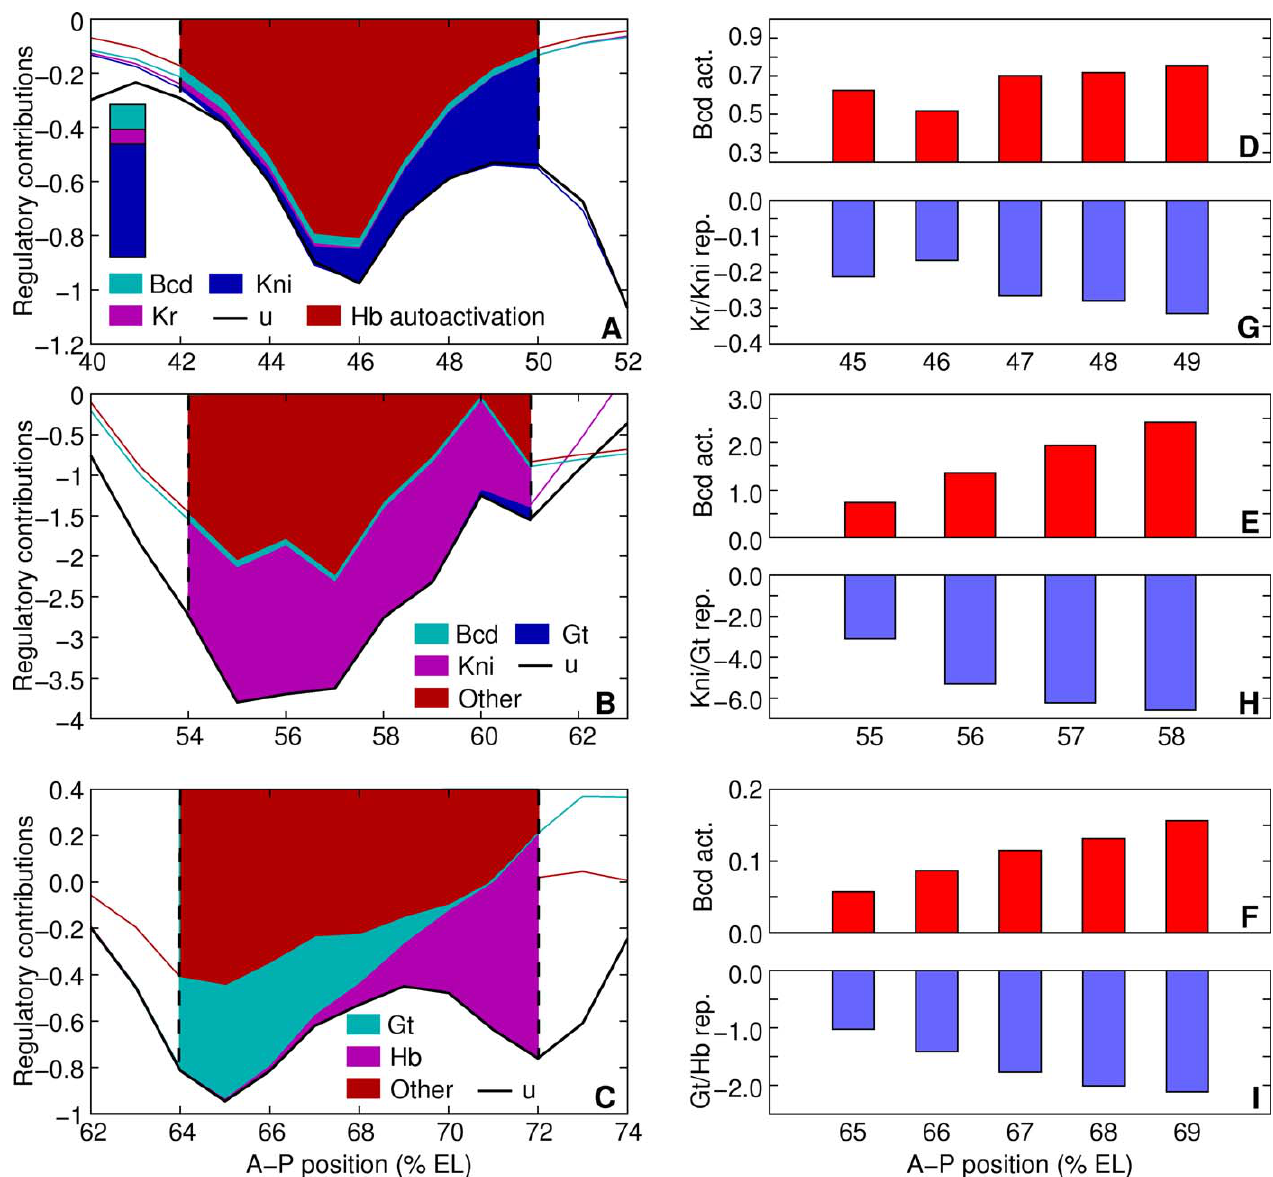
Figure 4. Regulatory Analysis of the Posterior Borders of the Anterior hb , the Central Kr , and the Posterior kni Domains (A–C) Analysis of the chosen gene circuit (see Results section ‘‘ Simulation of Bcd Variation and Size Variation ’’ ) with the median Bcd profile (Figure 2B). Dashed vertical lines demarcate a border, and correspond to positions where the expression is at 90% maximum and at 10% maximum. The solid black line is the spatial derivative of the total regulatory input to the gene u a (see Section S3 in Protocol S1). The area above the black line is the total change in total regulatory input u a that causes the border to form. The colored areas correspond to the contributions to the change in total input by different regulators of the gene. The regulatory inputs that cannot set a border are shown in red (see Section S3 in Protocol S1 for details), and are not included in the analysis. A regulatory contribution can be from an activator or a repressor depending on the sign of the regulatory parameter (see Table S1 in Protocol S1 for values). (A) The hb border forms because of the regulatory contributions of Bcd activation, Kr repression, and Kni repression. The contribution of Hb autoactivation, shown in red, does not set the border but merely sharpens it [9,36]. The colored bar inset shows the relative contributions of Bcd activation, Kr repression, and Kni repression to hb , showing that the repressive contribution is significant compared to the activating one. (B) The Kr border is set by Bcd activation and repression from Kni and Gt. (C) The kni border is set by repression from Gt and Hb. (D–I) The effects of simulated Bcd variation on the regulation of gap gene borders. (D–F) The average Bcd activation at a border in 88 simulations (with different Bcd profiles) pooled into 1% EL bins according to border position. (G–I) The average repression levels at a border in 88 simulations pooled into 1% EL bins according to border position. The repressors were identified in the regulatory analysis (A–C). The x- axis shows bin position. The analysis was performed on model output in time class